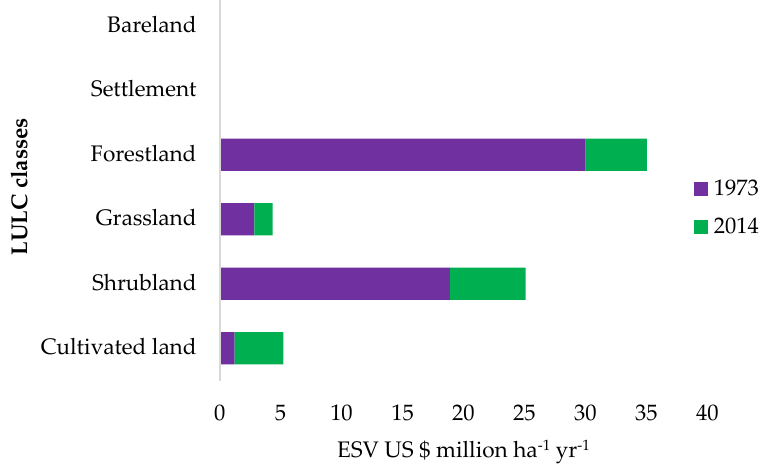
Figure 13. ESVs from 1973 to 2014 in Toke Kutaye, Ethiopia (Source of data: Tolessa et al. [56], but figure done by authors).